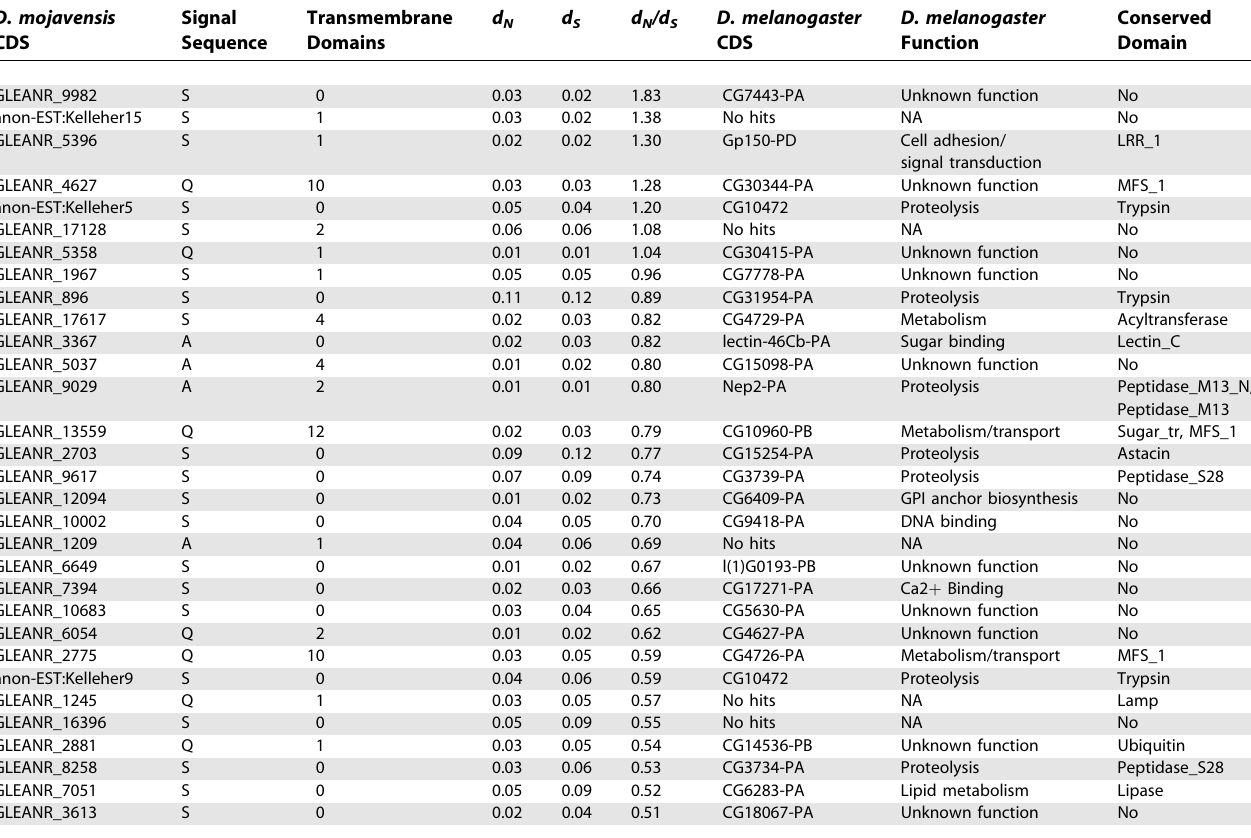
Table 1. Candidate Female Reproductive